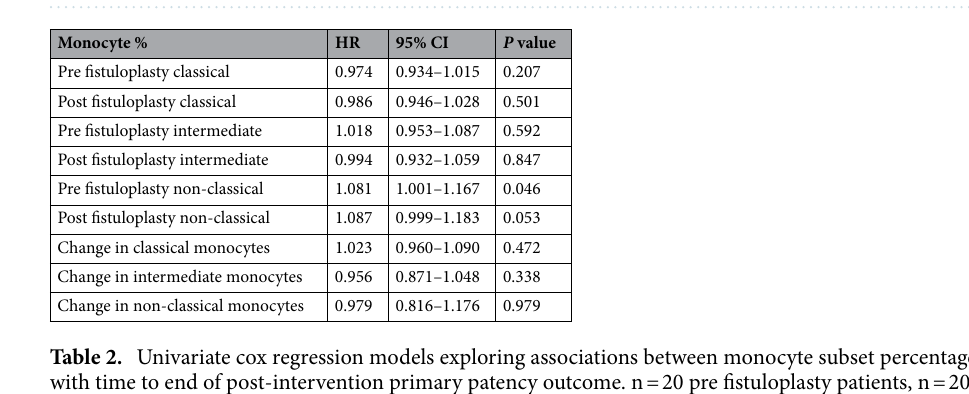
Figure 3. Absolute numbers of monocyte subsets in whole blood from multiple time points before, during, and after a fistuloplasty procedure. Graphs showing the absolute numbers of classical, intermediate and non-classical monocytes prior to the administration of contrast, immediately, 2, 3 and 24 h post fistuloplasty in five donors.